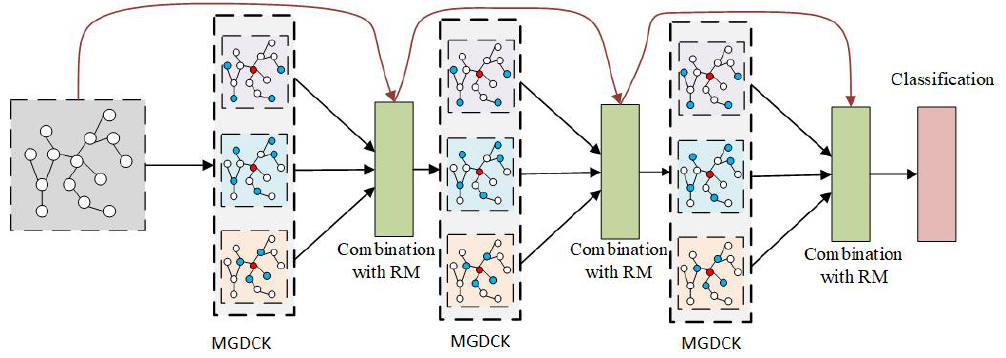
Figure 2. The architecture of Graph Dilated networks with Rejection mechanism